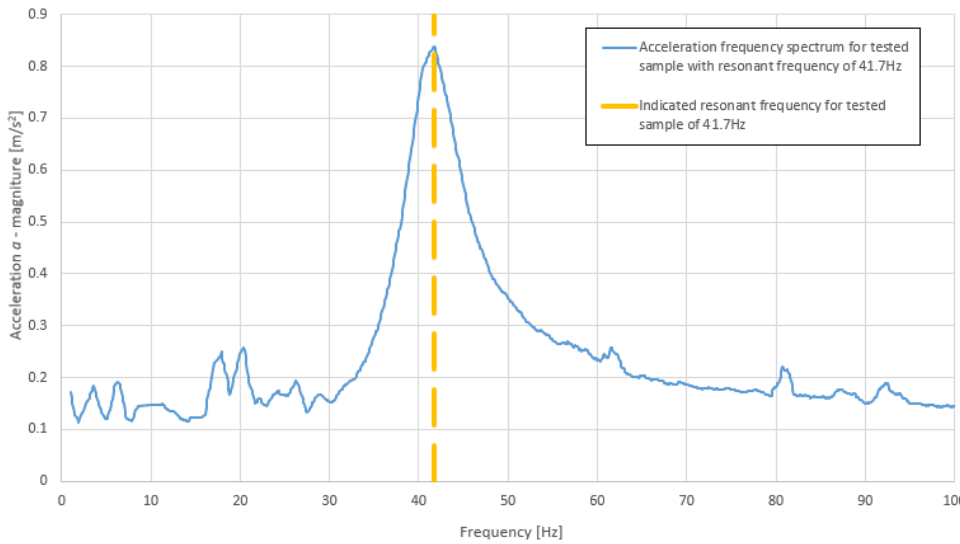
Figure 7. Acceleration frequency response spectrum of an example sample with indication of approximate resonant frequency (own elaboration).